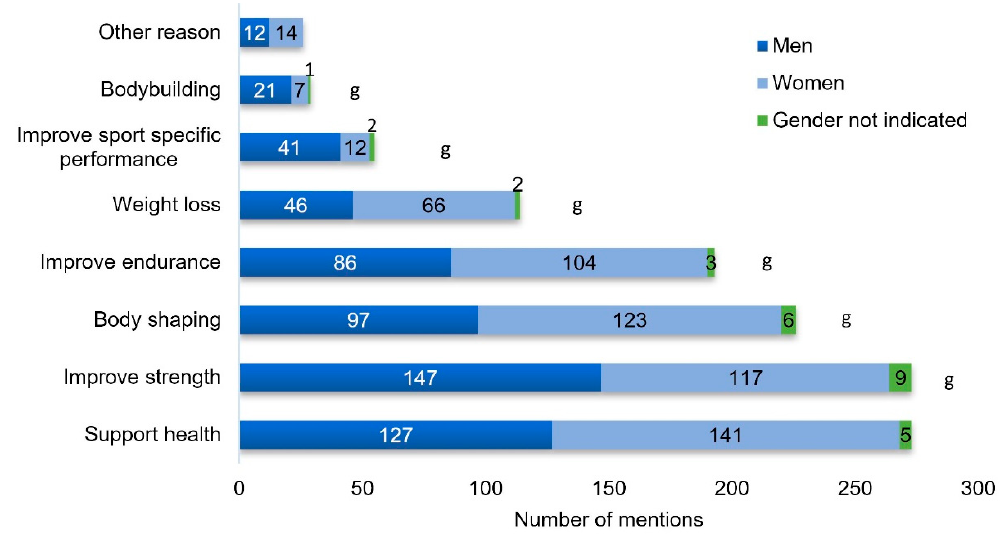
Figure 2. Training goals. g: Indicates significant gender effect ( p < 0.05). Multiple answers were possible.